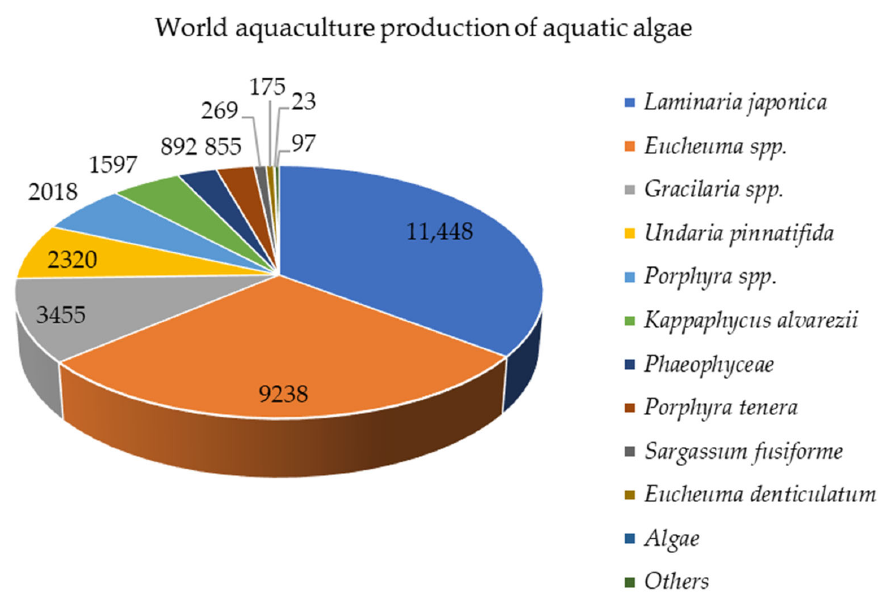
Figure 4. Global aquaculture production of aquatic algae in 2018 (thousands of tons, live weight) [31].